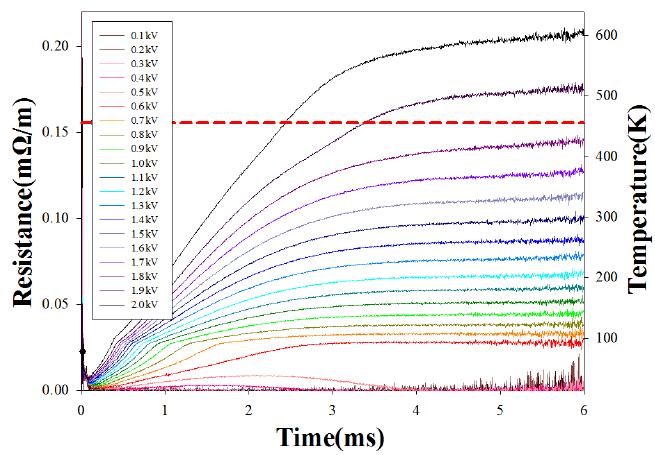
Figure 6. Transient resistance per meter of sample 4 under impact.